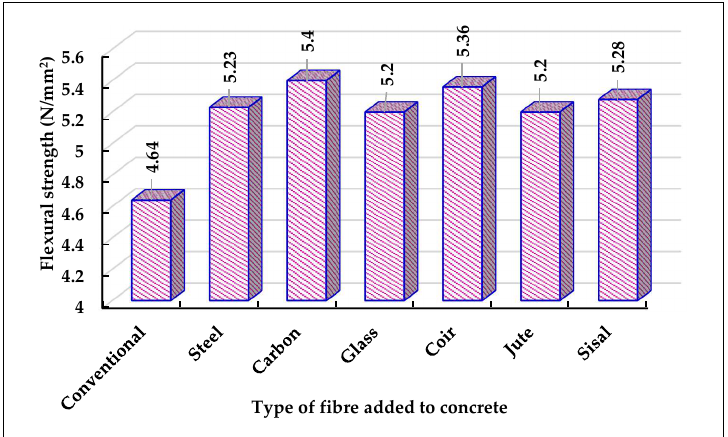
Figure 8. Graphical illustration of flexural strength of FRC.